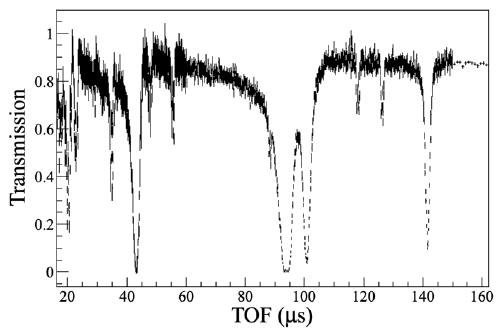
Figure 3. Measured natural Zn transmission.